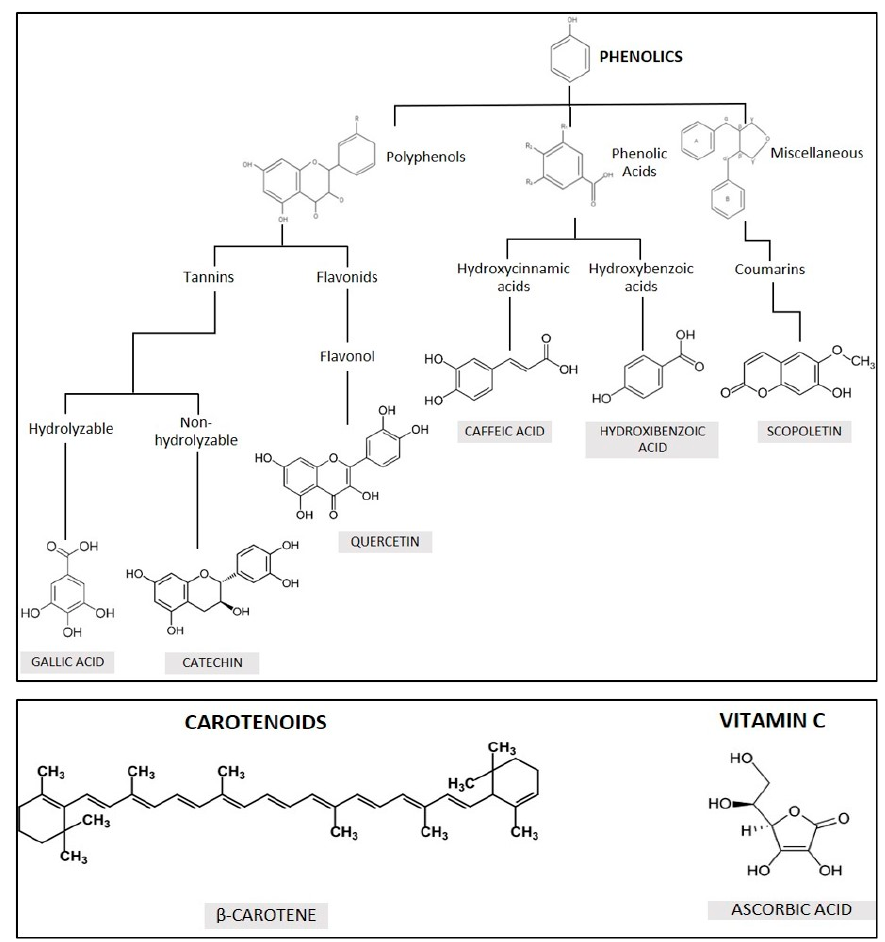
Figure 1. Natural non-enzymatic antioxidants present in plants and used in this